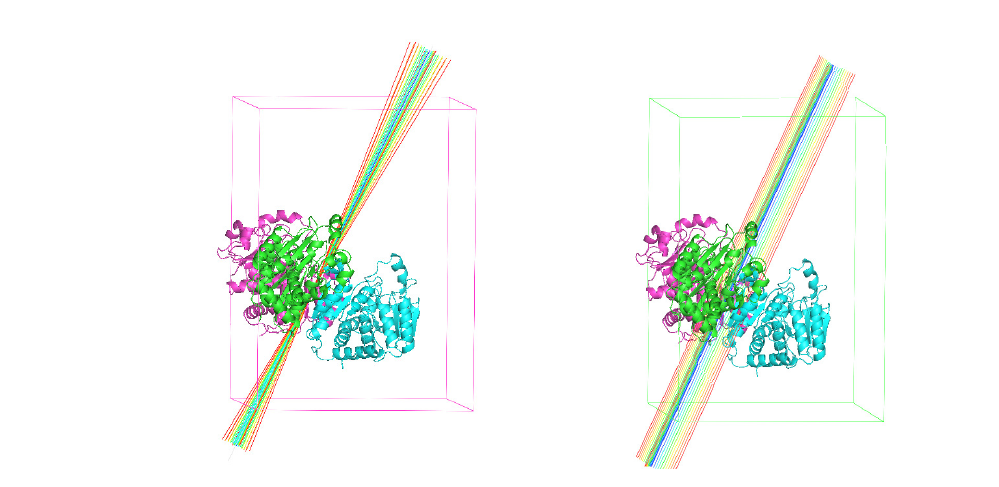
Figure 17. Variation of the 3-fold NCS axis of 4NF2 in orientation and location for testing the tolerance of the HIO